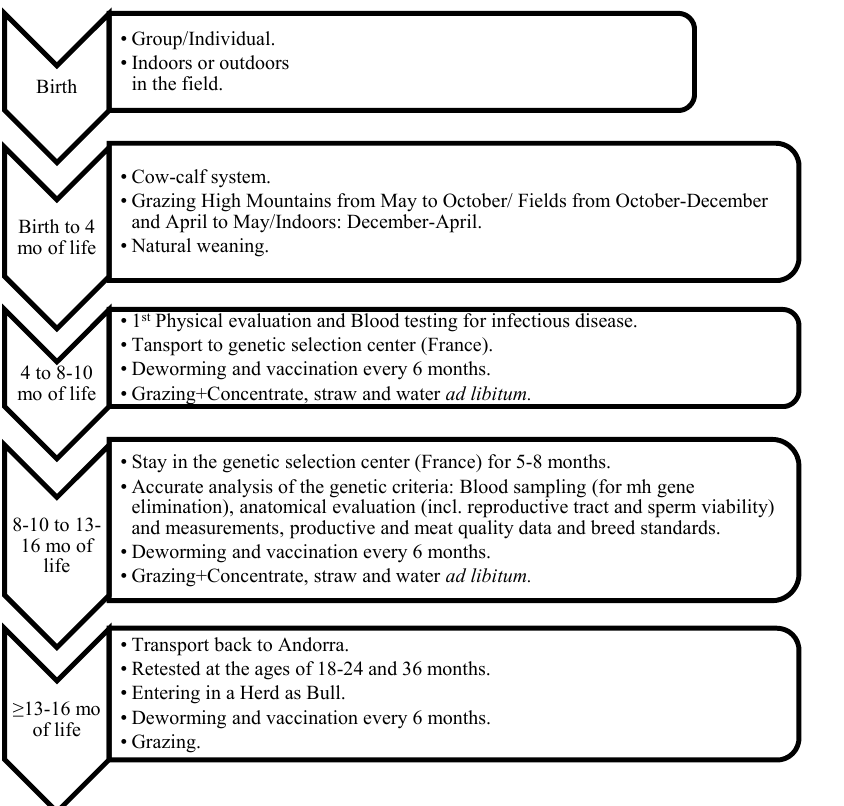
Figure 5. Management, nutritional, and husbandry protocols used during the calf and bull rearing process of BA males destined for bull replacement.